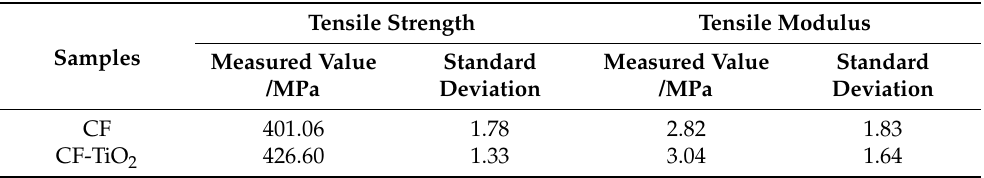
Table 2. Mechanical properties of CF and CF-TiO 2